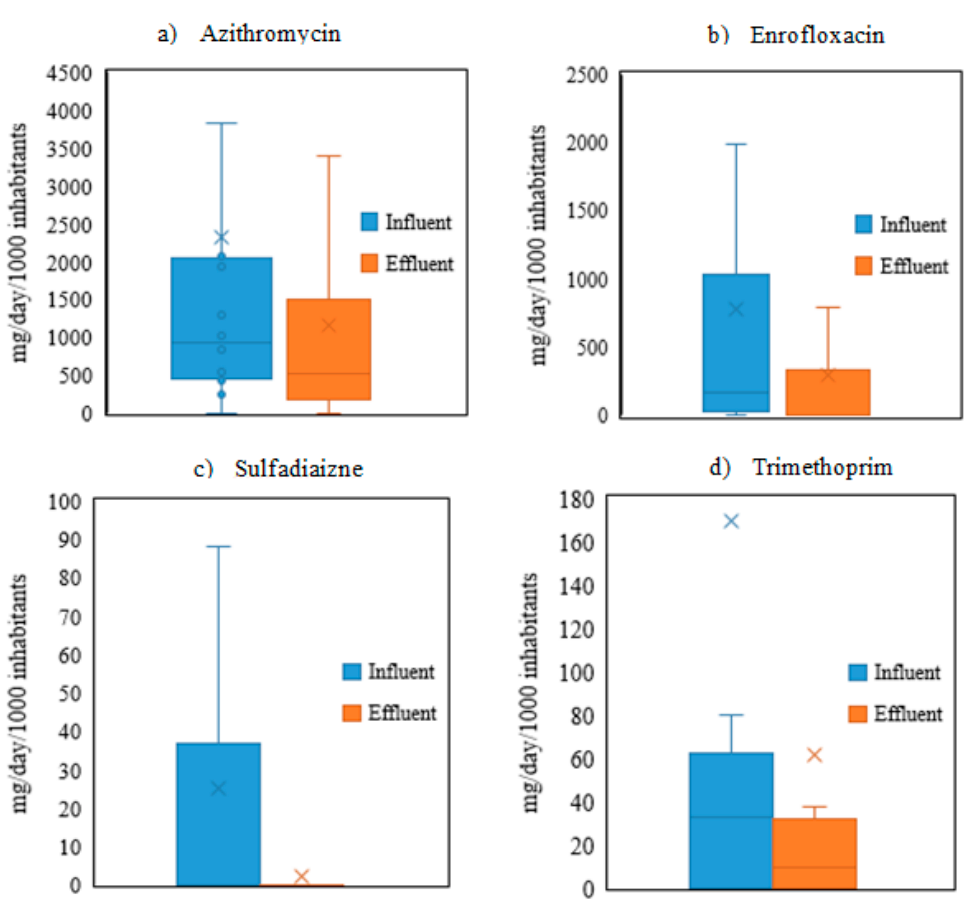
Figure 3. Boxplots of each antibiotic indicating total mass loading values: ( a ) azithromycin, ( b ) enrofloxacin, ( c ) sulfadiazine ( d ) trimethoprim.